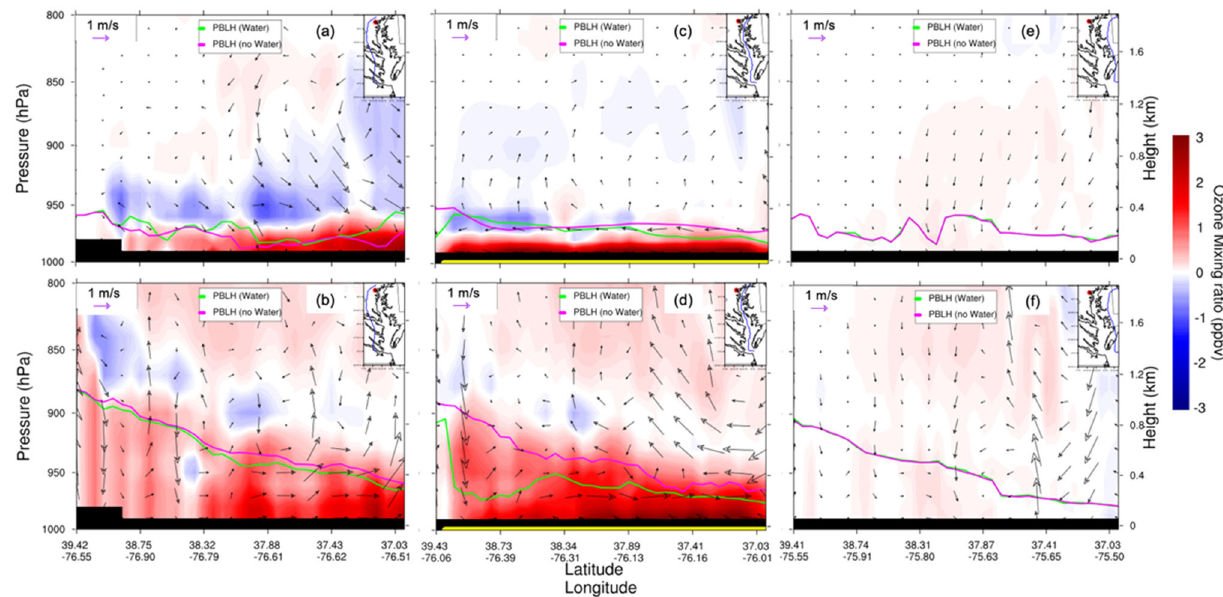
Figure 13. WRF–Chem-simulated O 3 mixing ratio vertical cross section (from north to south) differences (water minus nowater, night: ( a , c , e ); day: ( b , d , f )). The overlaid streamline is the corresponding surface wind difference. The green curve is the PBLH of water; the pink curve is the PBLH of nowater. CB is denoted with the yellow bar. Note that vertical wind is magnified by 50 times for illustration purposes. Daytime is defined as 1000–0000 UTC (or 06:00–20:00 local time); nighttime is defined as 0000–0900 UTC (or 00:00–06:00 and 20:00–00:00 local time).